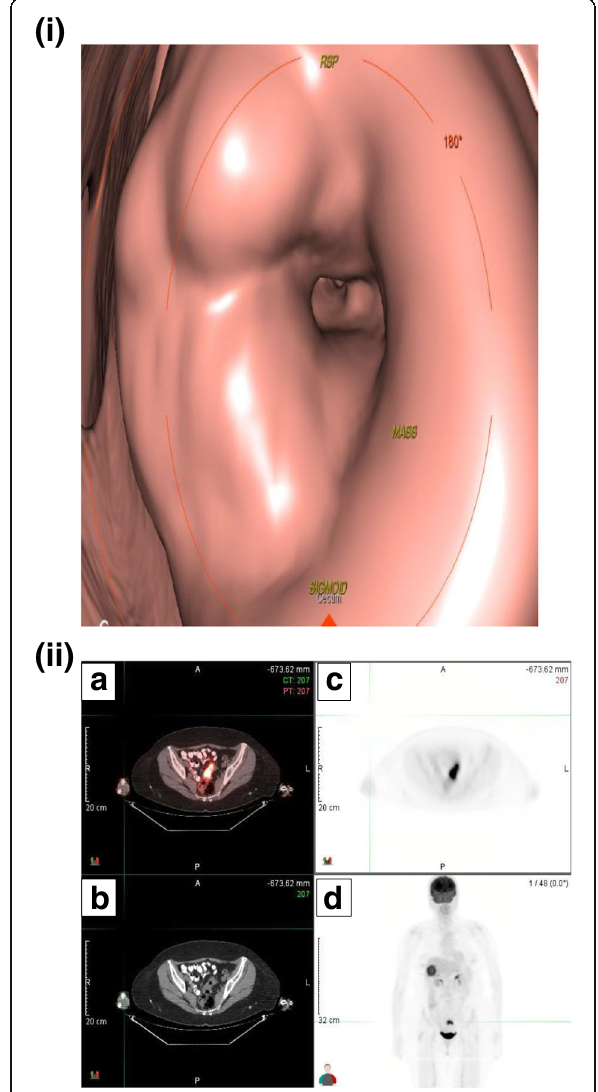
Fig. 2 A 76-year-old female. i CT colonography revealed 5-cm-long segment of concentrically thickened mid to distal sigmoid colon. ii FDG avid 5-cm-long segment of concentrically thickened mid to distal sigmoid colon. Pathologically proved sigmoid carcinoma with SUVmax 13.7. a Axial PET/CT. b Axial CT. c , d